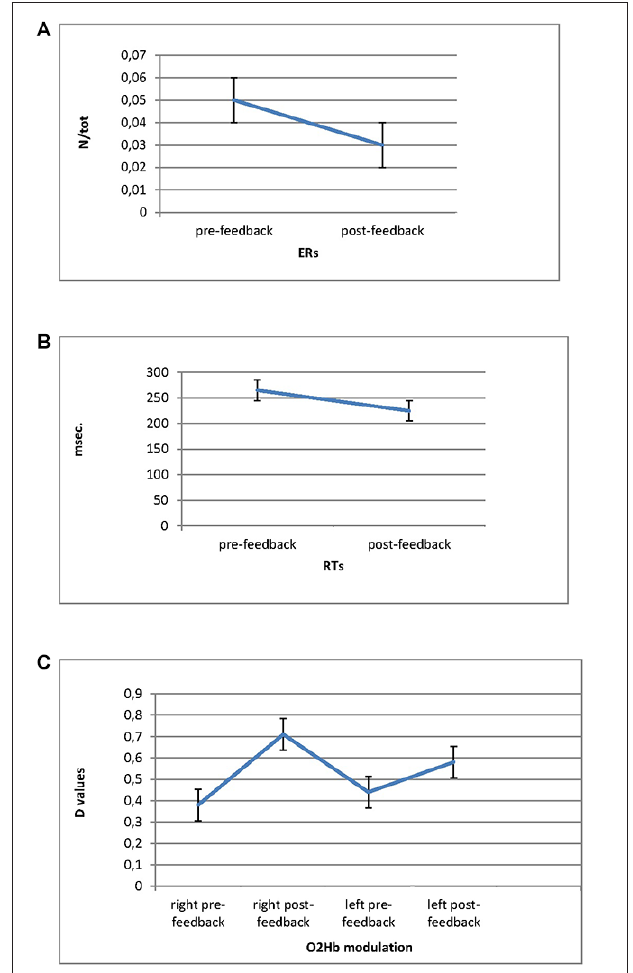
FIGURE 3 | Error Rates (ERs; A ) and Response Times (RTs; B ) modulation as a function of pre-feedback and post-feedback, with decreased values in post-feedback. (C) O2Hb modulation (D values) for Condition and Lateralization. Post-feedback condition revealed increased D values for the right prefrontal cortex